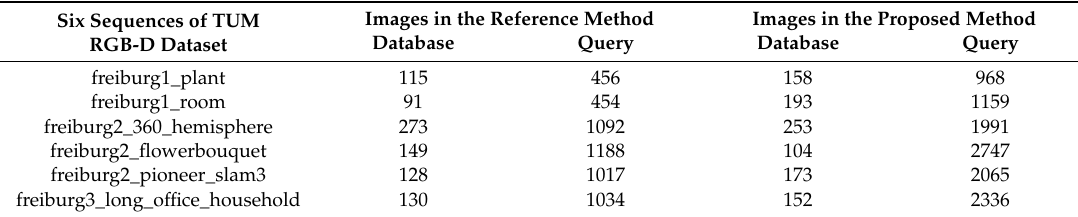
Table 3. The numbers of selected database images and query images in the reference method and the proposed method.